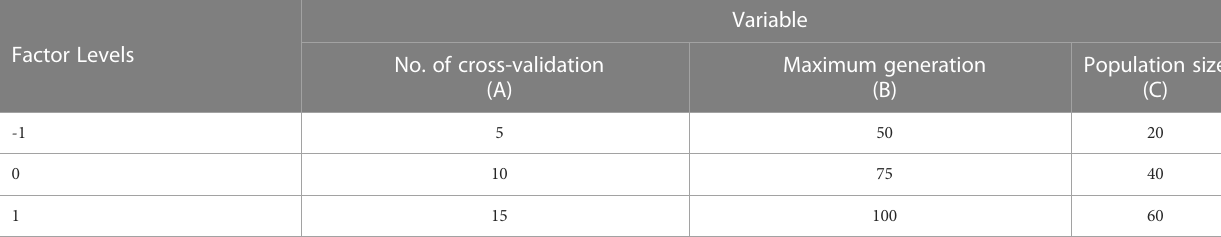
TABLE 4 Experimental values and coded levels of variable using Box – Behnken design.